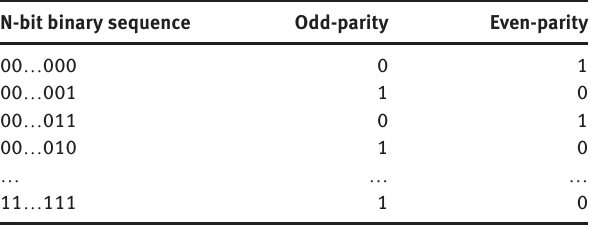
Table 1: Truth table of the proposed N-bit optical parity